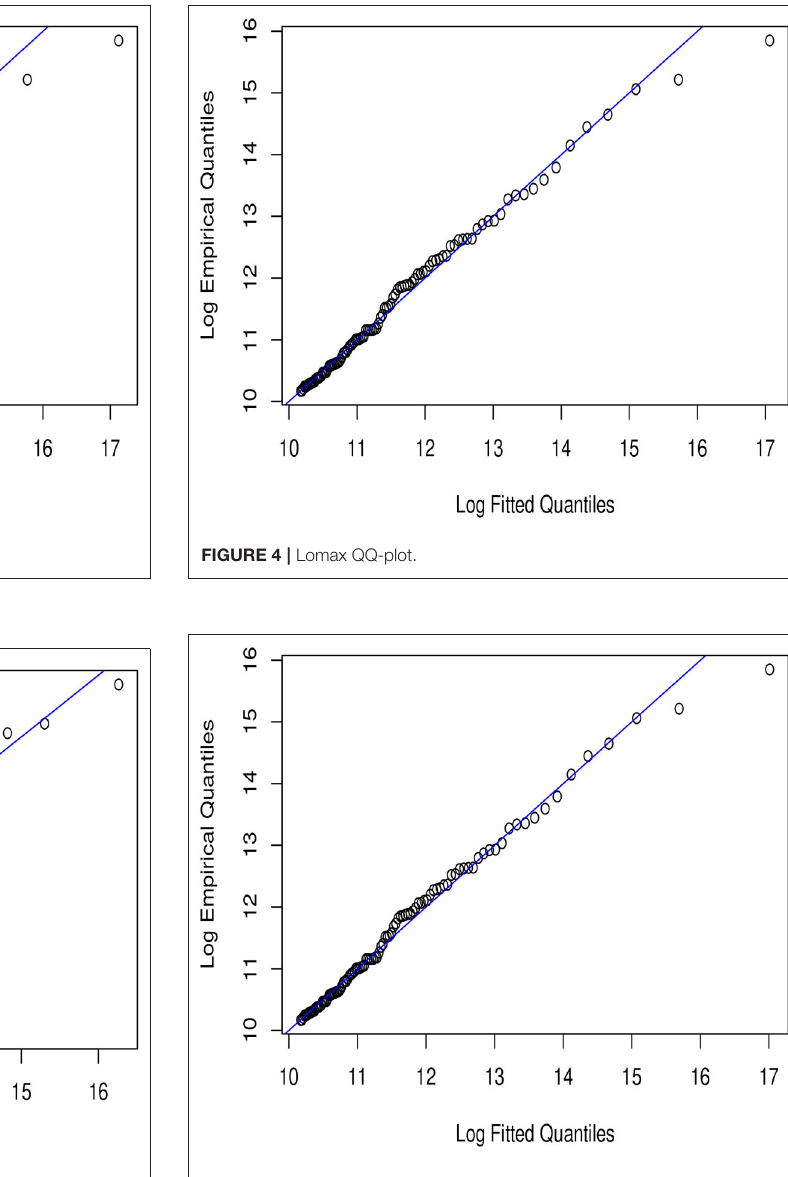
FIGURE 3 | Lognormal QQ-plot.